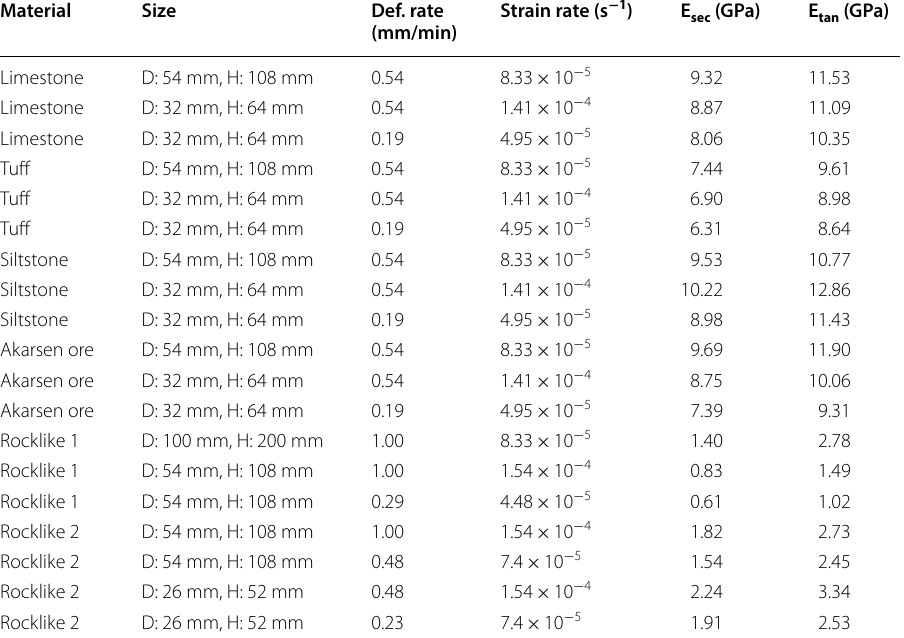
Table 5 Deformation modulus values (E modulus of elasticity)